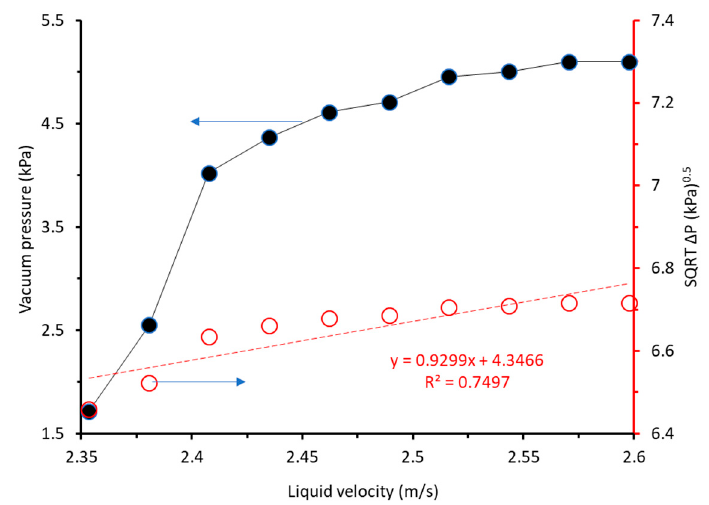
Figure 3. Effect of liquid velocity on the generated vacuum pressure in the venturi-orifice microbubble generator (left y-axis) and its relationship with the absolute pressure drop (right y-axis). The tests were run in the absence of air flow through the microbubble generator.